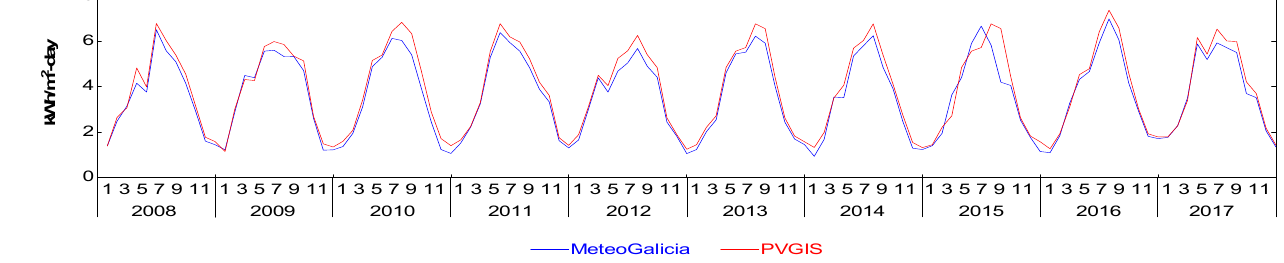
Figure 5. Evolution of the annual mean GHR index: PVGIS vs. MeteoGalicia (Santiago EOAS, 2008– 2017).